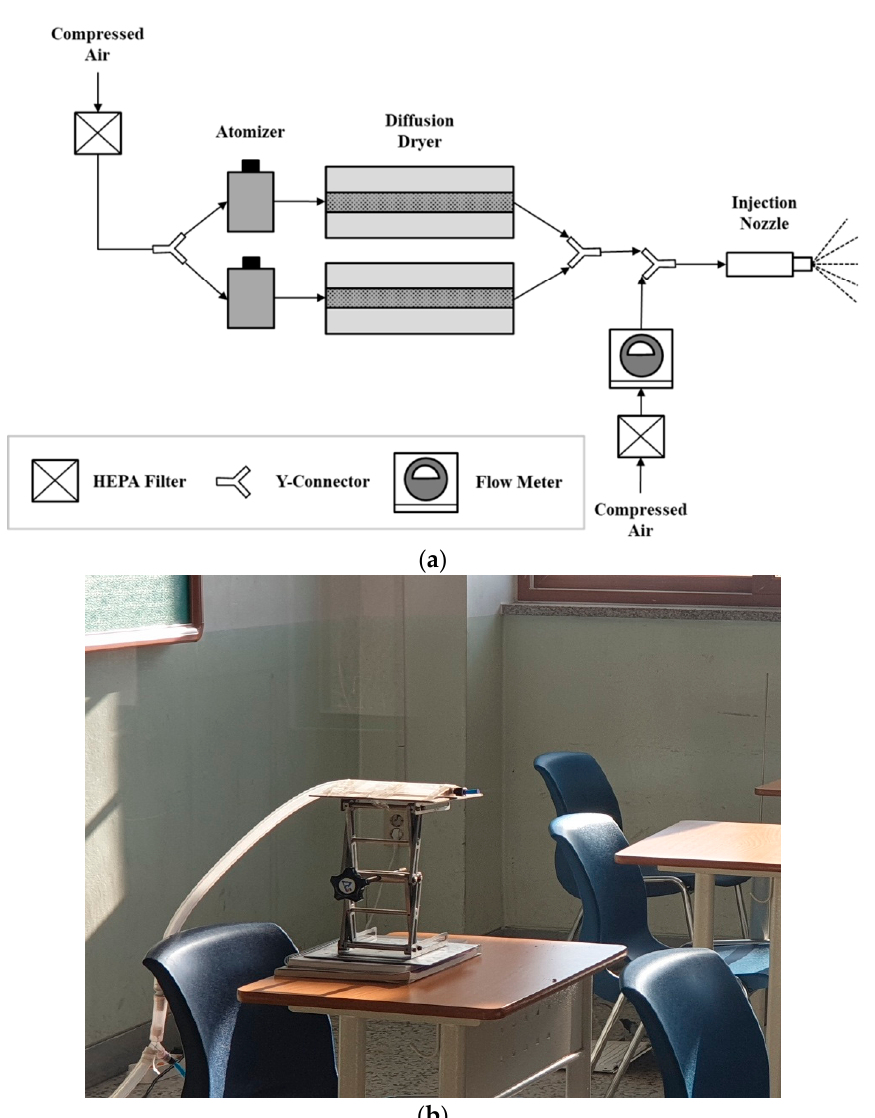
Figure 3. Experimental setup: ( a ) schematic of the particle injection system; ( b ) photograph of the injection nozzle.